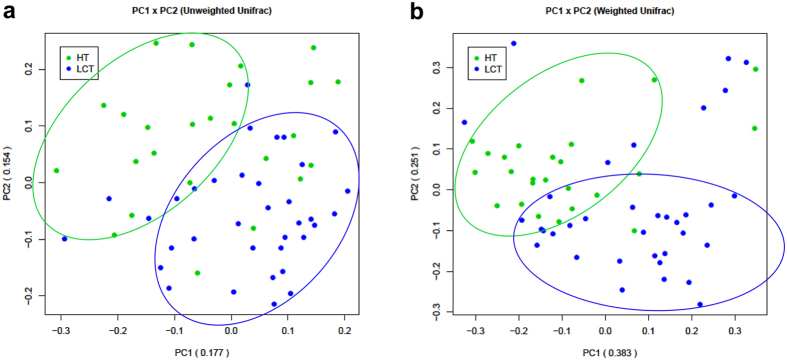
Bacterial diversity clustering by combining unweighted and weighted UniFrac PCoA of tongue coat microbiota.(a) Unweighted UniFrac (qualitative); (b) Weighted UniFrac (qualitative). Each symbol represents a sample (blue, LCT; green, HT); the variance explained by the PCs is indicated in parentheses on the axes. LCT, liver cancer patients tongue coat; HT, healthy subjects tongue coat.